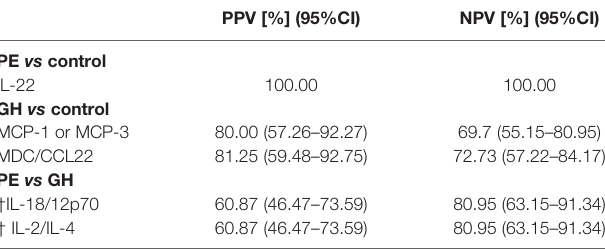
TABLE 4 | Diagnostic test